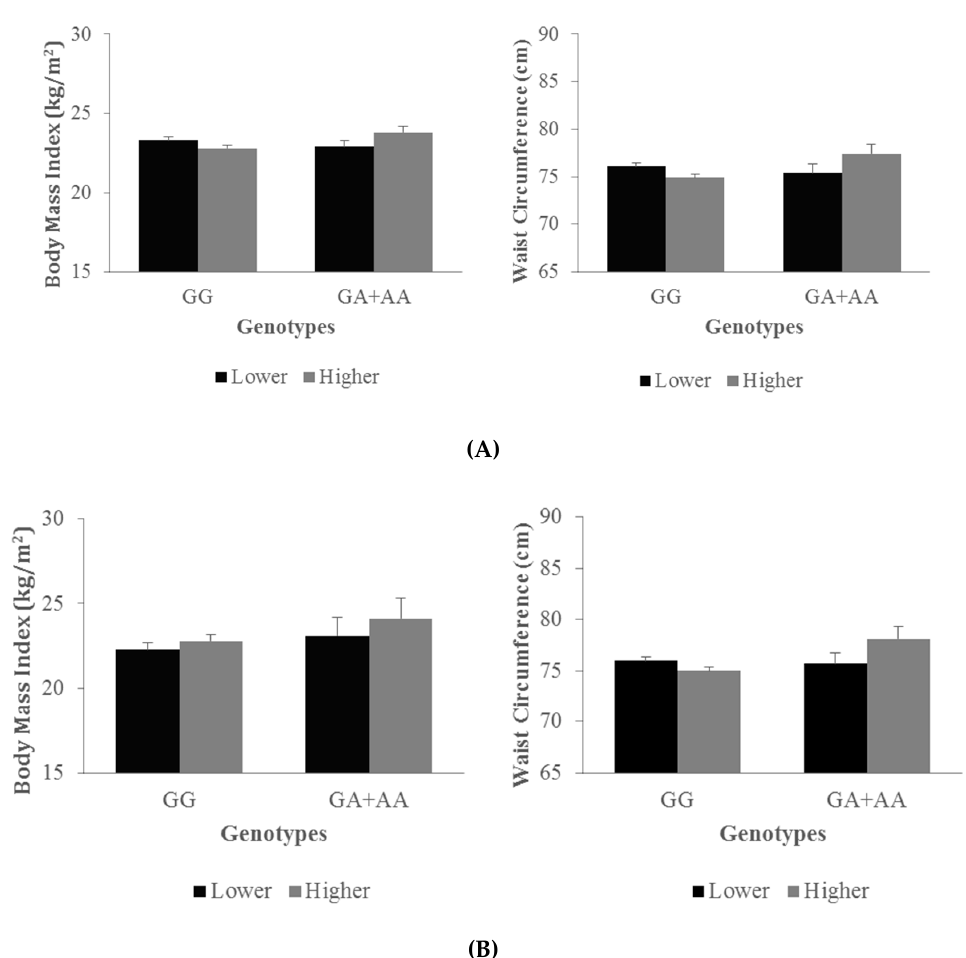
Figure 2. Interactions between the plasma lower (black—below the median) and higher (grey—above the median) n-6/n-3 ratio groups and NFKB1 rs4648090 ( A ) and rs4648022 ( B ) genotypes on BMI ( p = 0.02 and 0.06, respectively) and WC ( p = 0.03 and 0.04, respectively). P for gene–diet interactions on BMI and WC were tested using a general linear model adjusted for caloric intake, physical activity, age, sex, and race/ethnicity. Abbreviations: BMI, body mass index; WC, waist circumference.